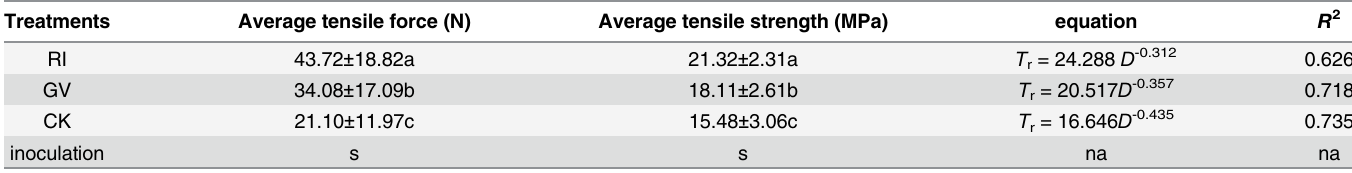
Table 3. Effect of AM fungi on the root tensile force and strength of R . pseudoacacia , and the power law equation describe relationships between root tensile strength ( T r ) and root diameter ( D ).